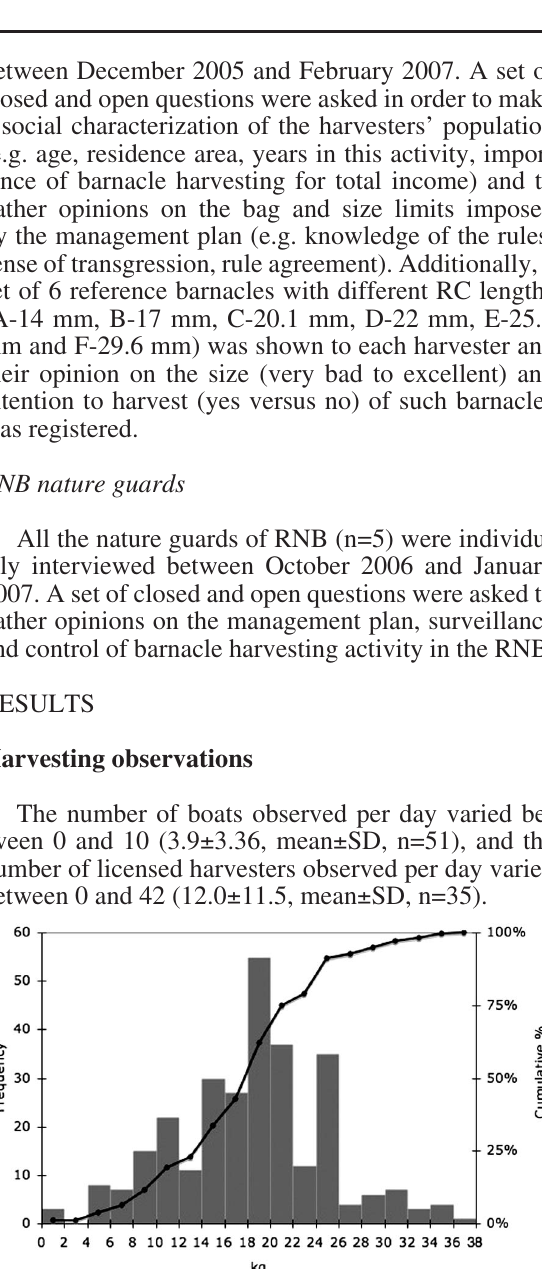
Table 1. – Summary of the management plan for Pollicipes pollicipes harvesting enforced since 2000 in the Berlengas Nature Reserve (RNB). Temporal closures Harvesting is not allowed during August and September, on Mondays, Fridays, weekends and holidays, and at night. Spatial closures Permanent no-take zones (zone C) were defined in the RNB area. Rotational harvest Harvesting is spatially limited to the intertidal area of zone A during odd years and of zone B during even years. Bag limit A maximum amount of 20 kg day -1 per harvester (without sorting) is allowed. Size limit At least 50% of the harvest volume must contain individual barnacles with a rostro-carinal length >25mm. Technique Harvesters are allowed to exploit intertidal barnacle populations during low tide or high tide (by free diving) with the aid of a spatula.